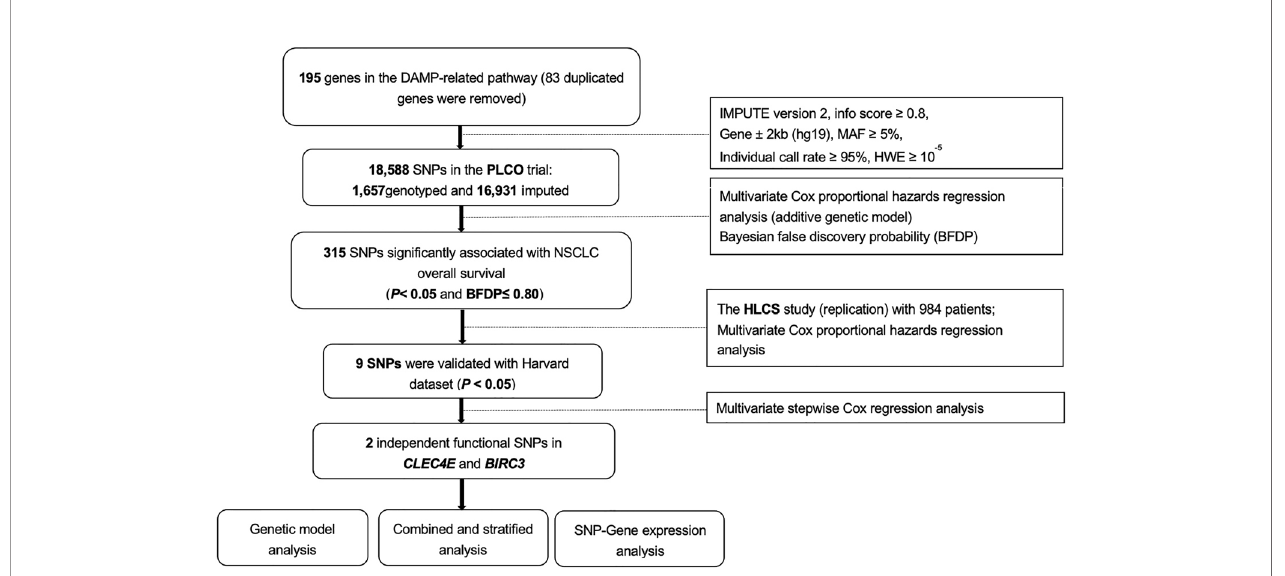
FIGURE 1 | The overall procedures of the present study. DAMP, damage-associated molecular pattern; SNPs, single-nucleotide polymorphisms; MAF, minor allelic frequency; HWE, Hardy-Weinberg Equilibrium; PLCO, The Prostate, Lung, Colorectal and Ovarian Cancer Screening Trial; HLCS, the Harvard Lung Cancer Susceptibility Study; NSCLC, non-small cell lung